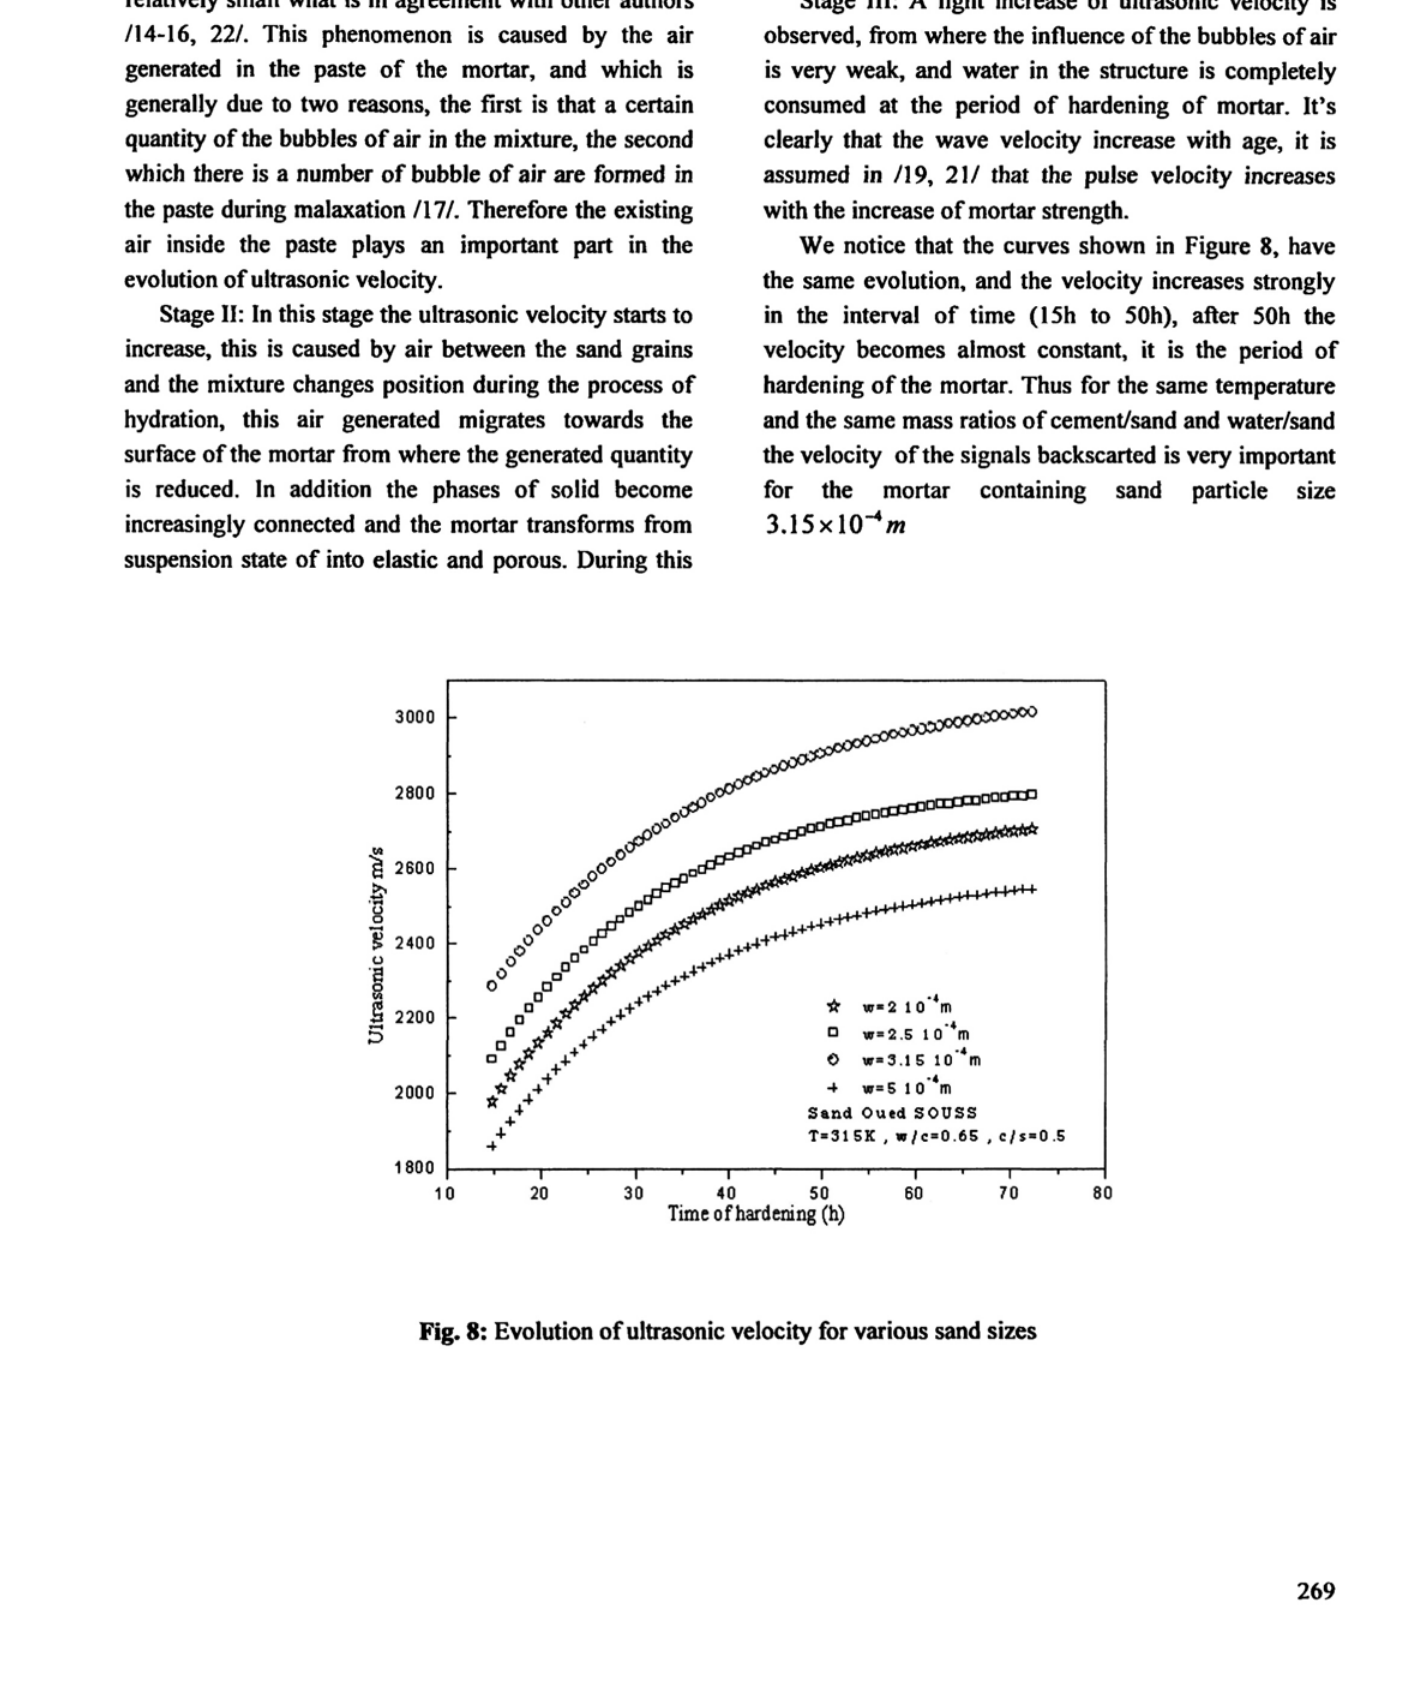
Fig. 8: Evolution of ultrasonic velocity for various sand